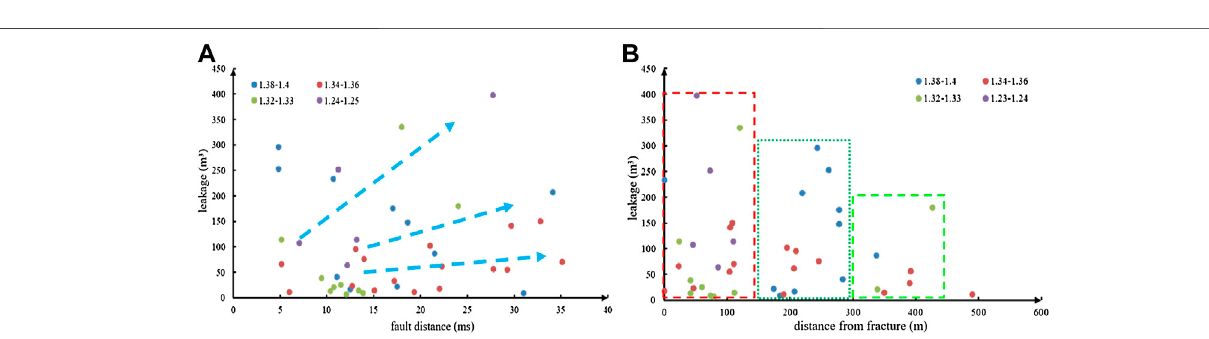
FIGURE 10 | Relationship between Silurian mud leakage and fault throw and its distance from wellbore to fault. (A) Relationship between leakage and fault distance; (B) Relationship between leakage and distance to fracture.